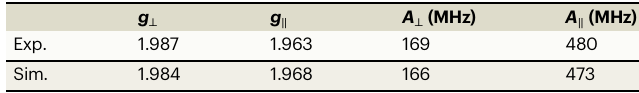
Table 1 | Simulated and experimental 27 spin Hamiltonian parameters for